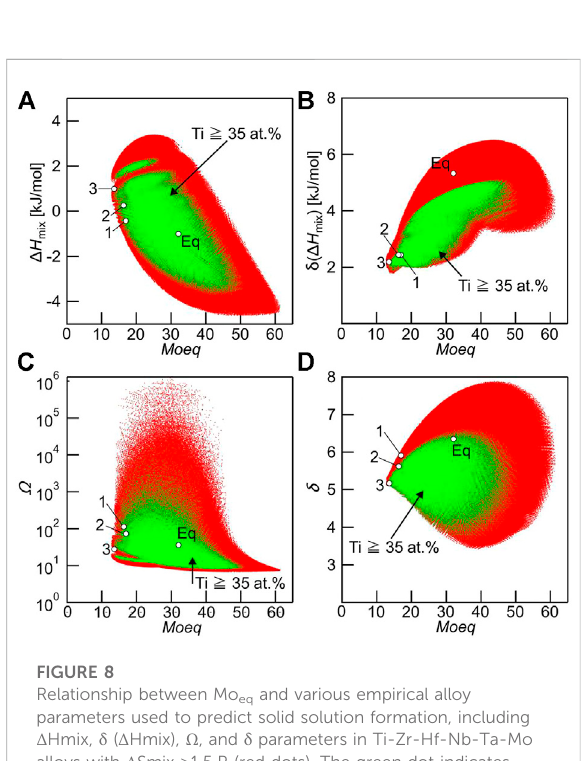
FIGURE 8 Relationship between Mo eq and various empirical alloy parameters used to predict solid solution formation, including Δ Hmix, δ ( Δ Hmix), Ω , and δ parameters in Ti-Zr-Hf-Nb-Ta-Mo alloys with Δ Smix ≥ 1.5 R (red dots). The green dot indicates the alloys whose Ti concentration was at and above 35 at% and considered the Ti-rich alloys. Hollow black circles ( ○ ) indicate the Ti – Zr – Hf – Nb – Ta – Mo alloy investigated in the present study.